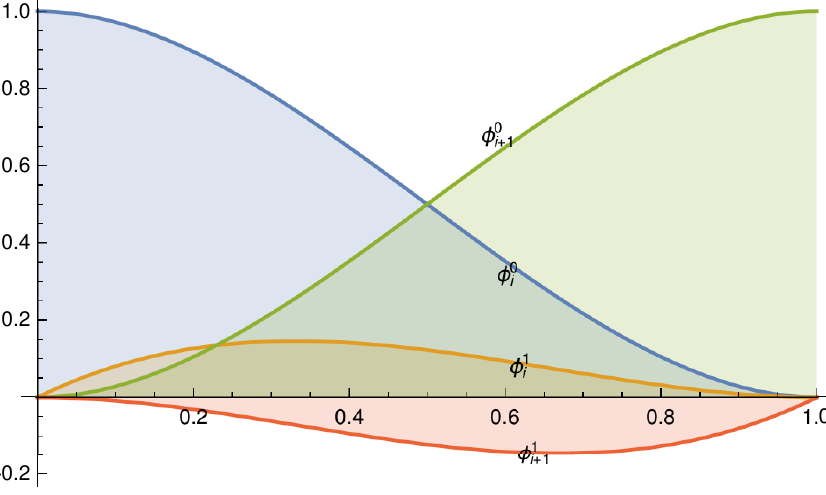
Figure 1. Plots of the basis functions on [ x i , x i + 1 ] = [ 0,1 ]